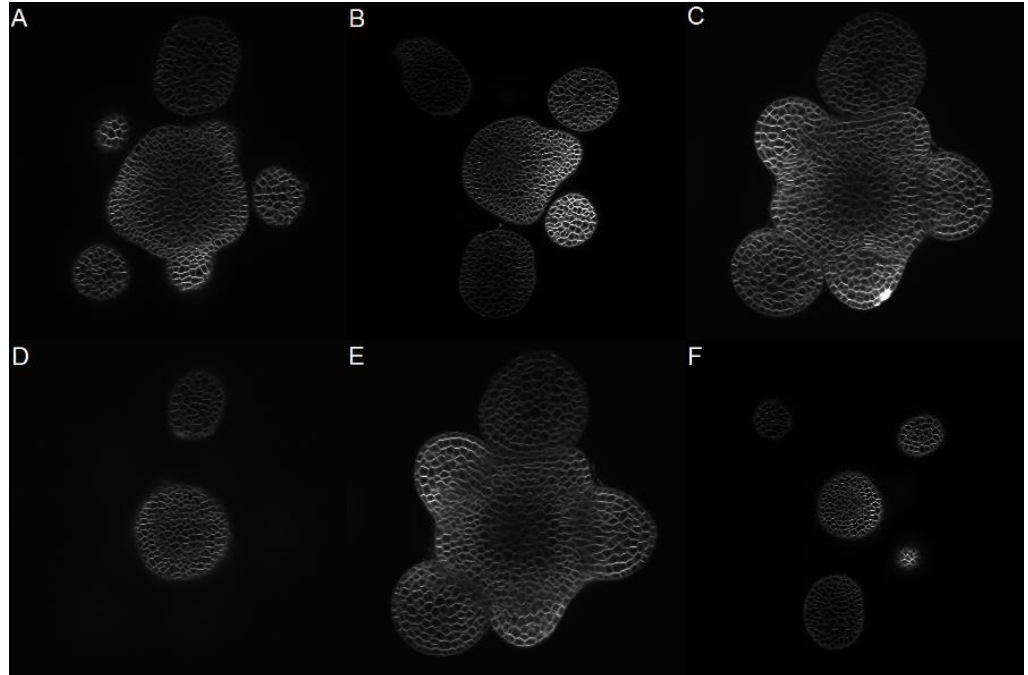
Figure 1. Sample images of the meristem stacks. Figure 1. Six sample images taken from two of the meristem stacks used, in this work, for the evaluation of the proposed